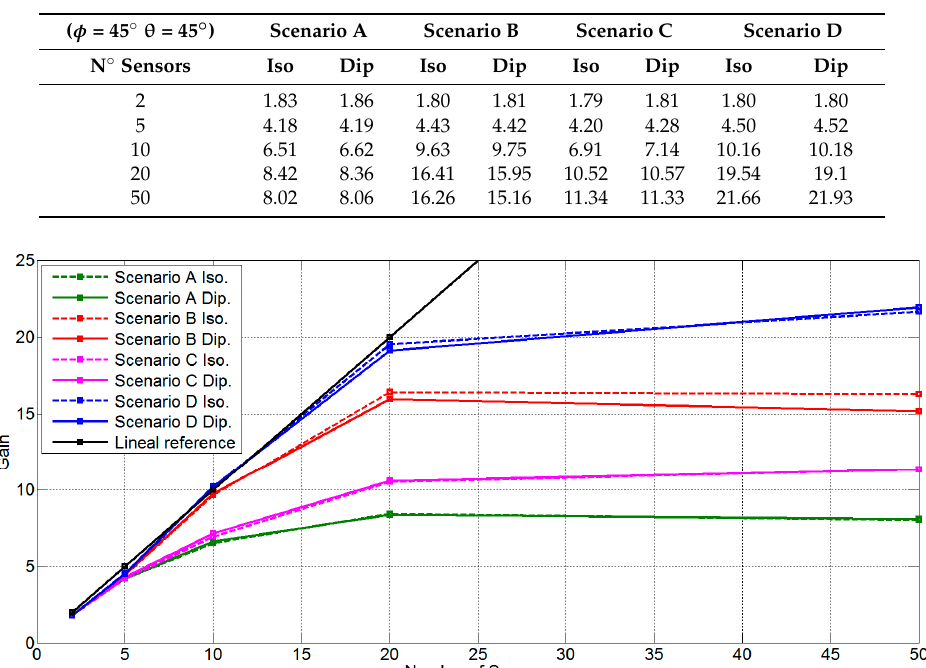
Figure 7. Gain results for two, five, 10, 20 and 50 sensors with φ = 45 ◦ and θ = 45 ◦ . Isotropic ideal antenna and scenario B in subfigure ( a ) ( upper left ), dipole antenna and scenario B in subfigure ( b ) ( upper right ) isotropic antenna and scenario D in subfigure ( c ) ( lower left ) and dipole antenna and scenario B in subfigure ( d ) ( lower right ). Table 1. Mean gain factor for all scenarios with two antenna and φ = 45 ◦ , θ = 45 ◦ .